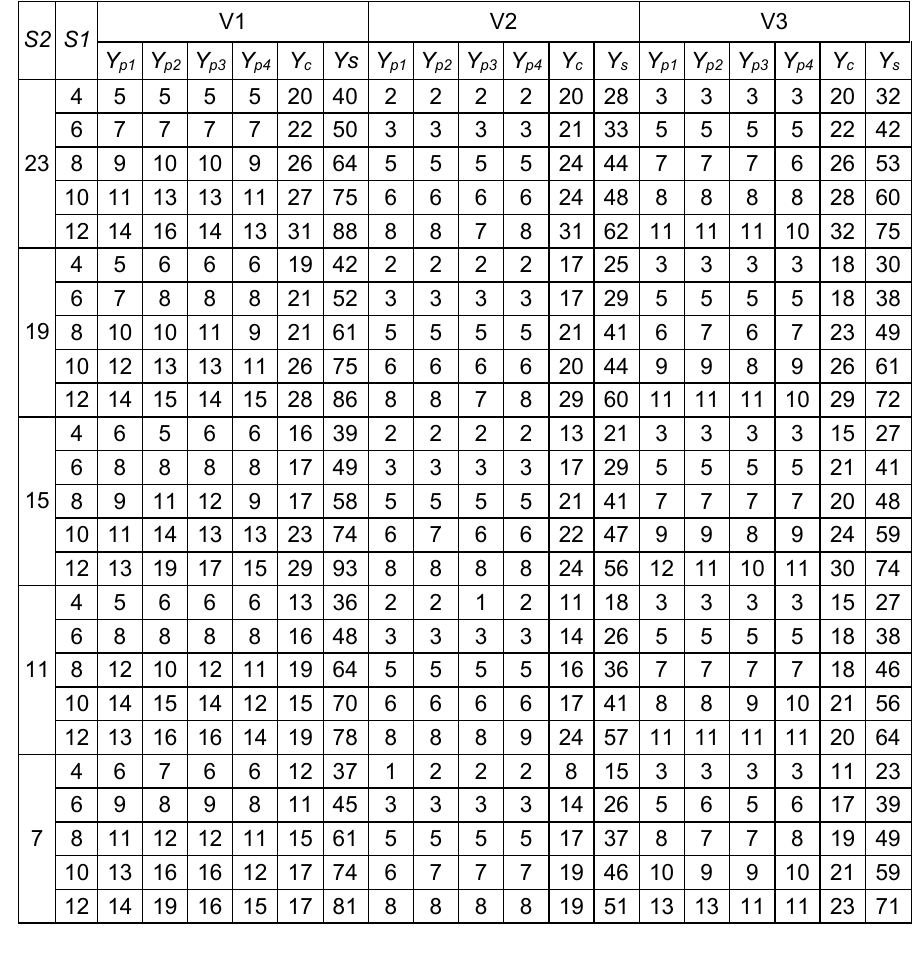
Table 1 – Average levels of inventory in the central warehouse, the peripheral warehouse, and in the whole system Таблица 1 – Средний уровень запасов на центральном и периферийном складах и в общей